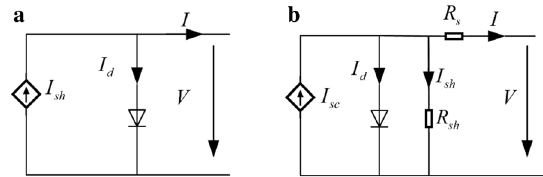
Fig. 1 Equivalent circuit of Solar cell a ideal, b practical